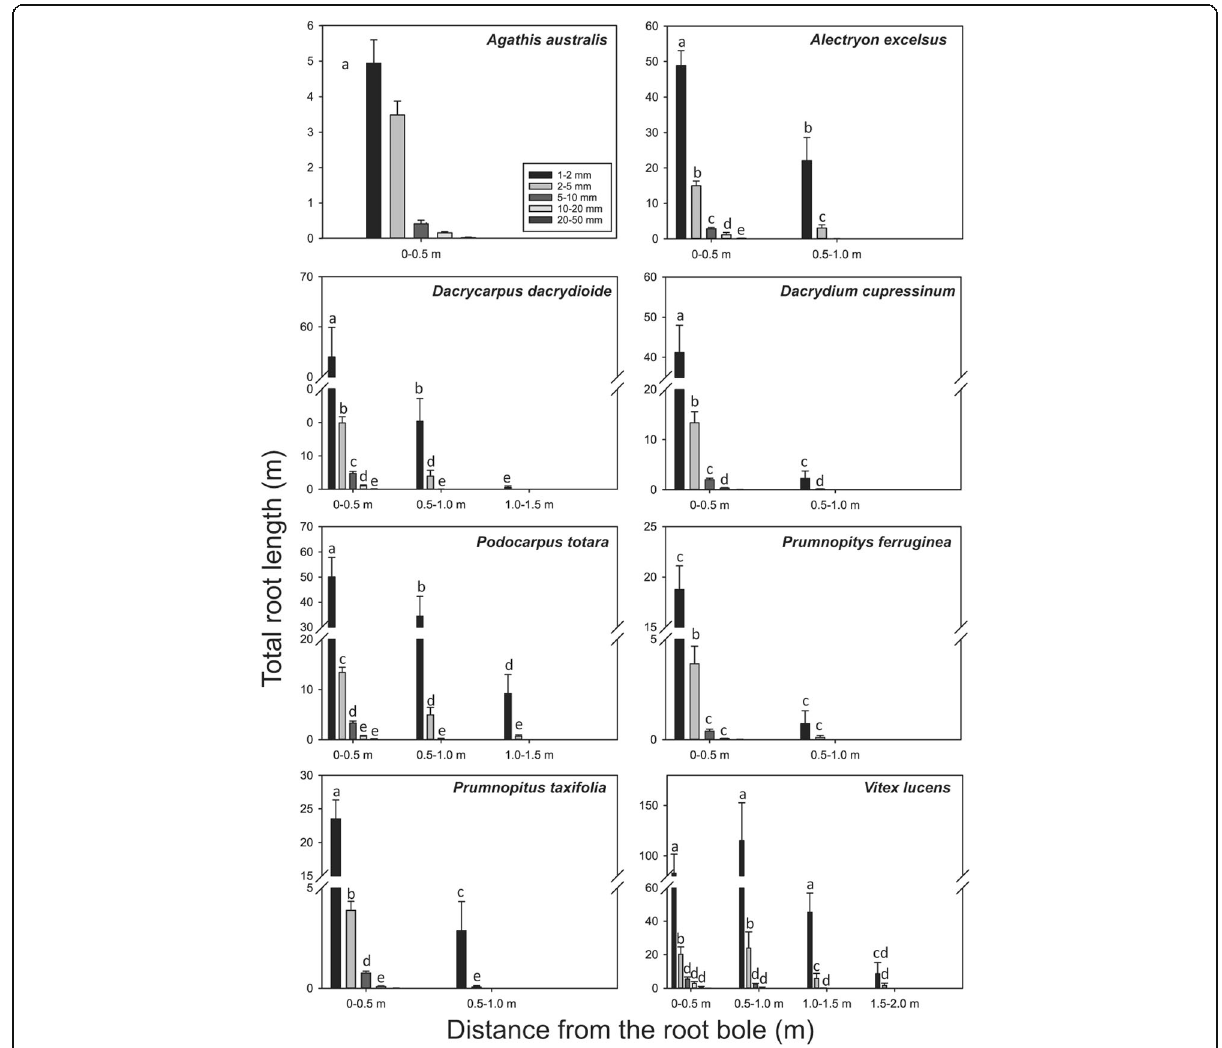
Fig. 11 Distribution of total root length with increasing radial increments from the root bole. Note that for the species with the greatest total root length there is a break in the y axis